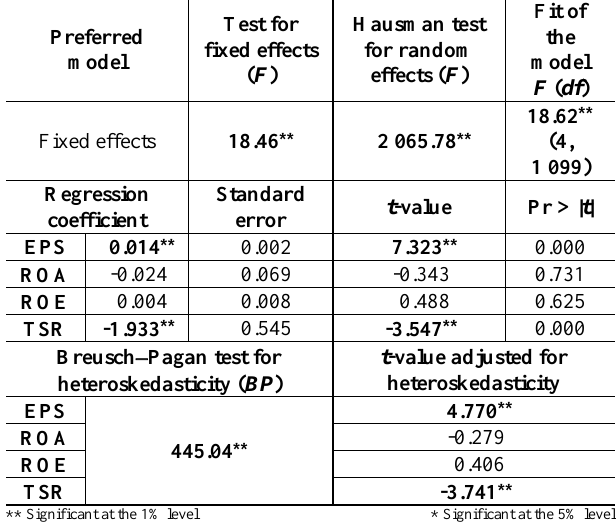
Table 5: Regression analysis results for CGS and EPS, ROA, ROE and